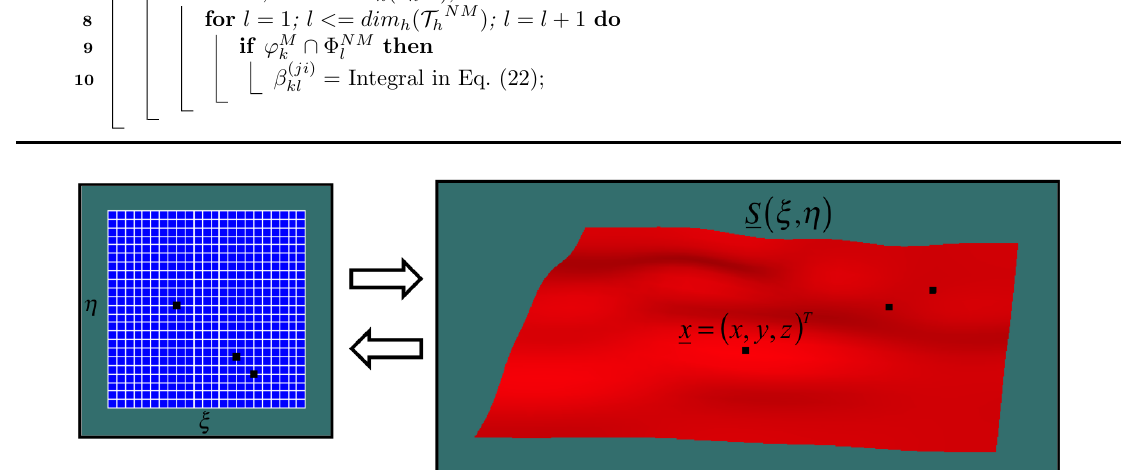
Figure 3. Physical space to computational mappings and vice-versa.